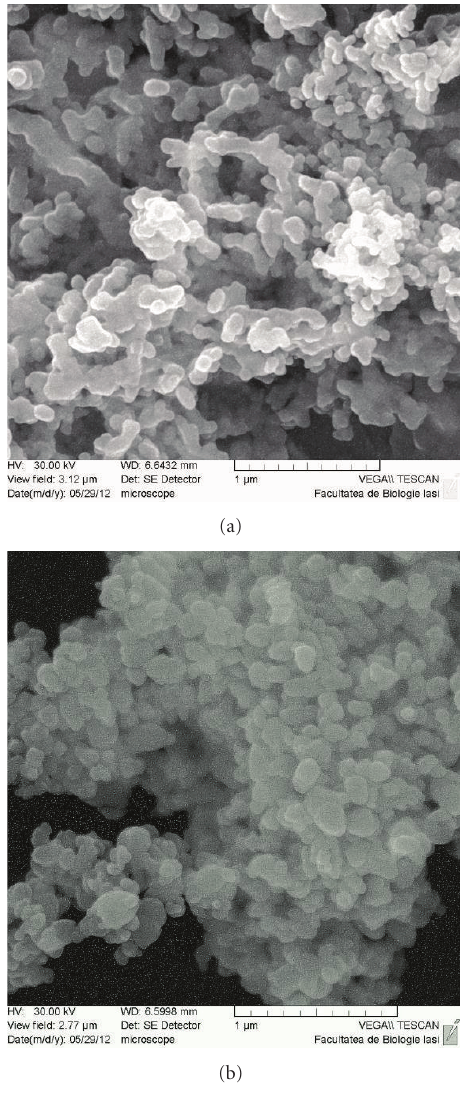
Figure 4: SEM images of ZnO-urea (a) and ZnO-NaOH